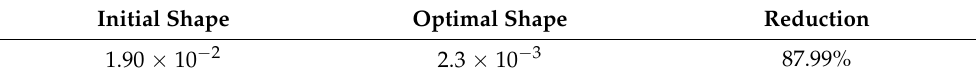
Table 6. Reduction in the norm of gradient of the objective function (Test case I).